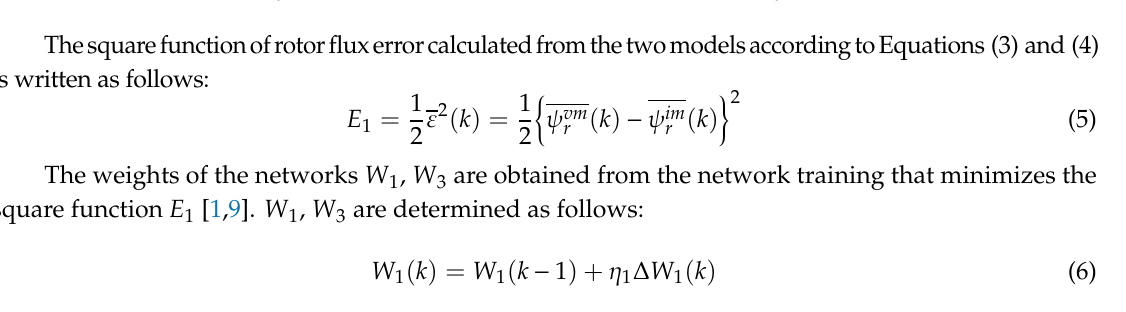
Figure 2. Two-layered neural network used to estimate rotor flux by the current model.